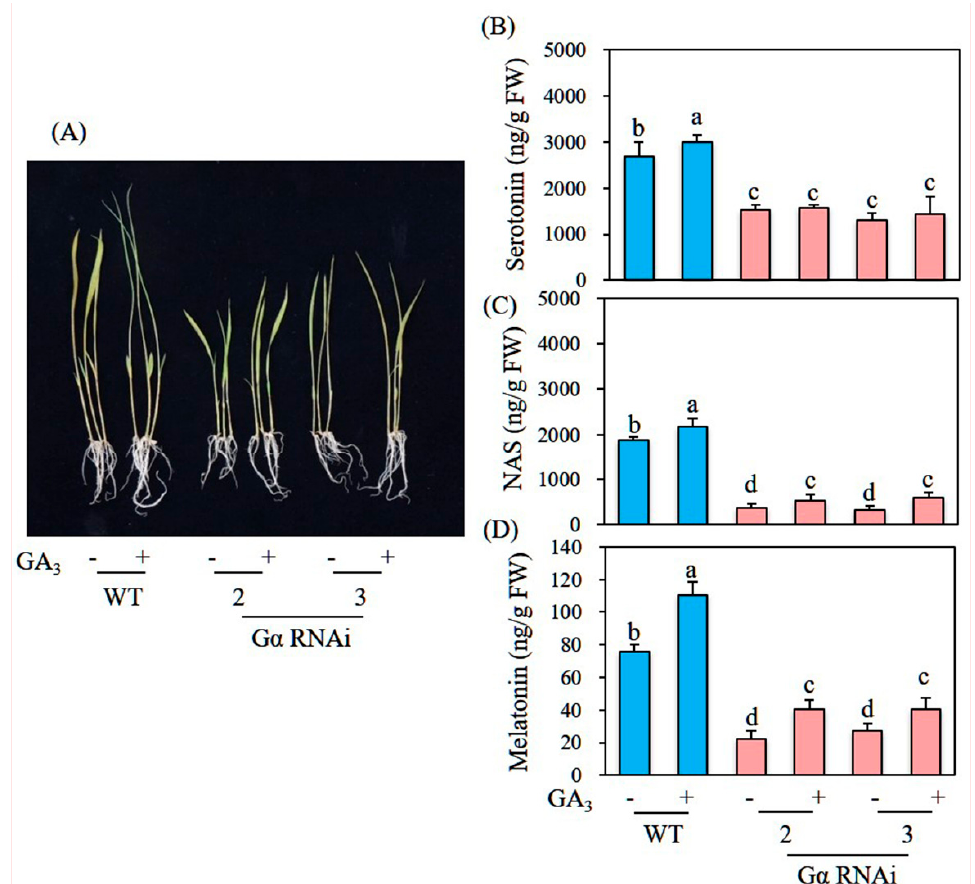
Figure 7. Effect of GA3 in the G α RNAi lines. ( A ) Seedling phenotypes in response to GA 3 (10 µ M) treatment for 24 h, followed by treatment with 0.5 mM cadmium for 3 days. ( B ) Serotonin levels after GA 3 and cadmium treatment. ( C ) N -Acetylserotonin levels after GA 3 and cadmium treatment. ( D ) Melatonin levels after GA 3 and cadmium treatment. Seven-day-old rice seedlings of WT and T 2 homozygous G α RNAi lines were used. Data are means of three replicates. Different letters denote significant differences ( p < 0.05; ANOVA, followed by Tukey’s HSD post hoc